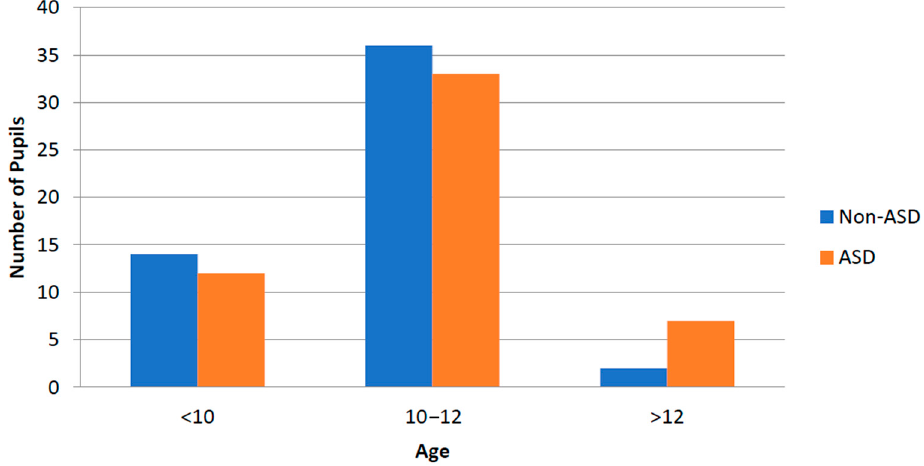
Figure 6. Range of the ages of the subjects.